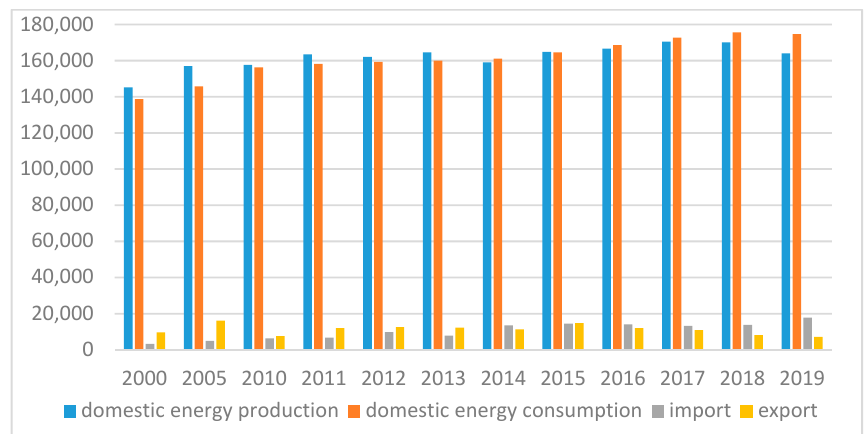
Figure 2. Poland’s energy balance for 2000–2019 (in GWh).